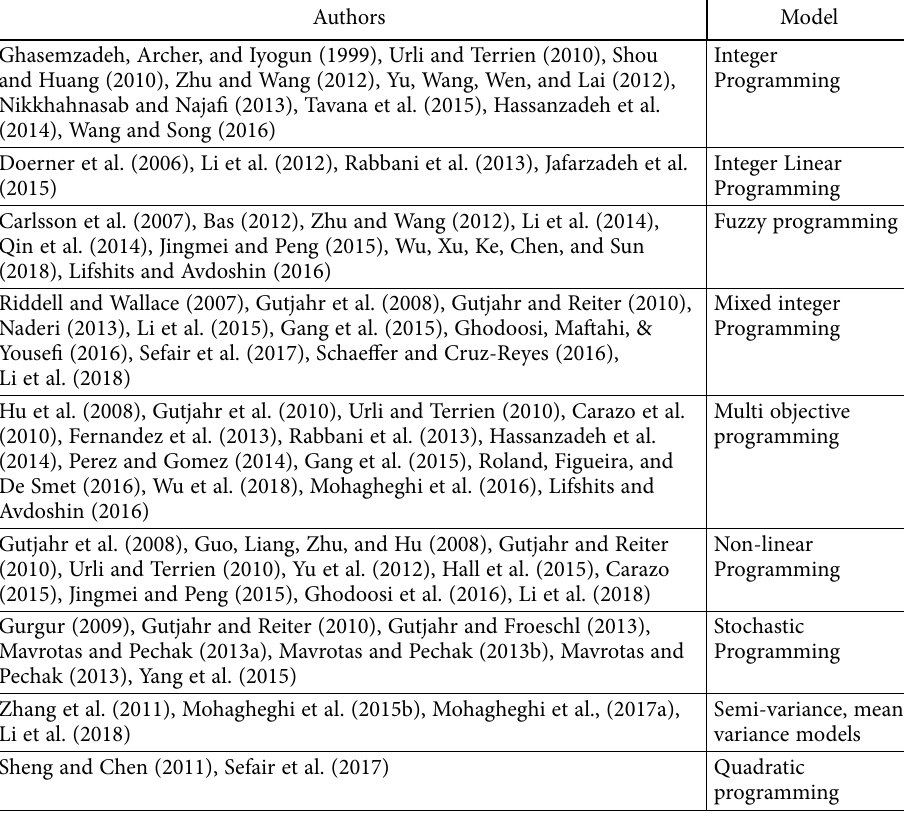
Integer Programming